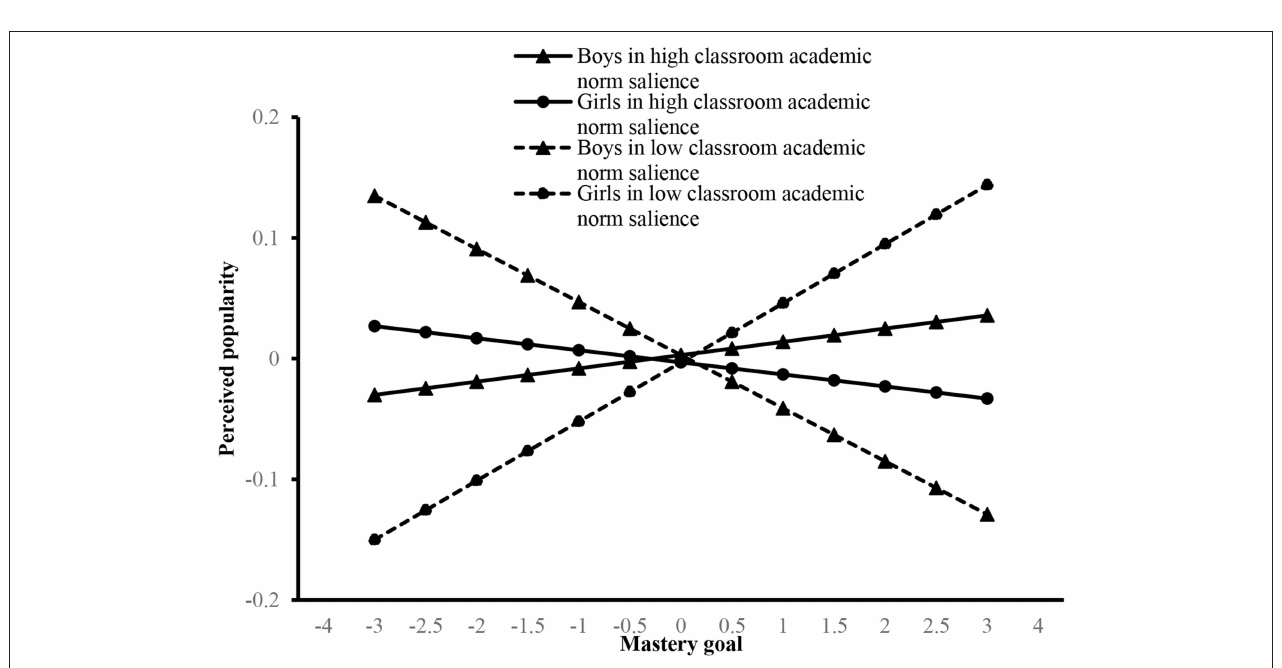
FIGURE 3 | Moderating effects of classroom academic norm salience and gender on relations between master goals and perceived